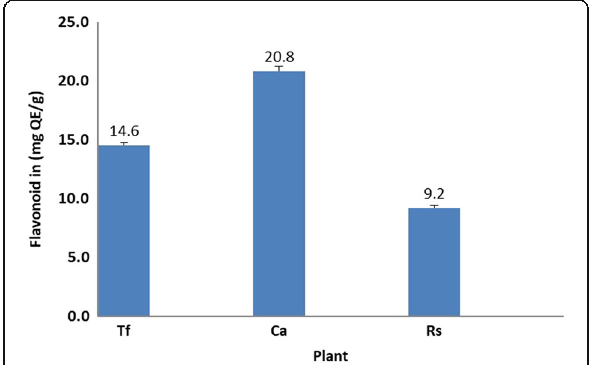
Fig. 4 Flavonoids content of the tested